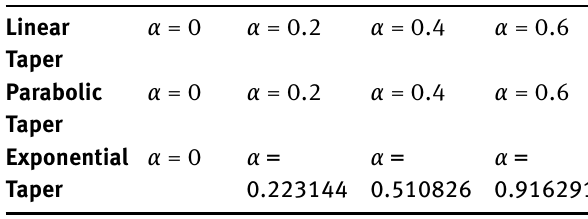
Table 2: Values of taper parameter for different taper patterns.